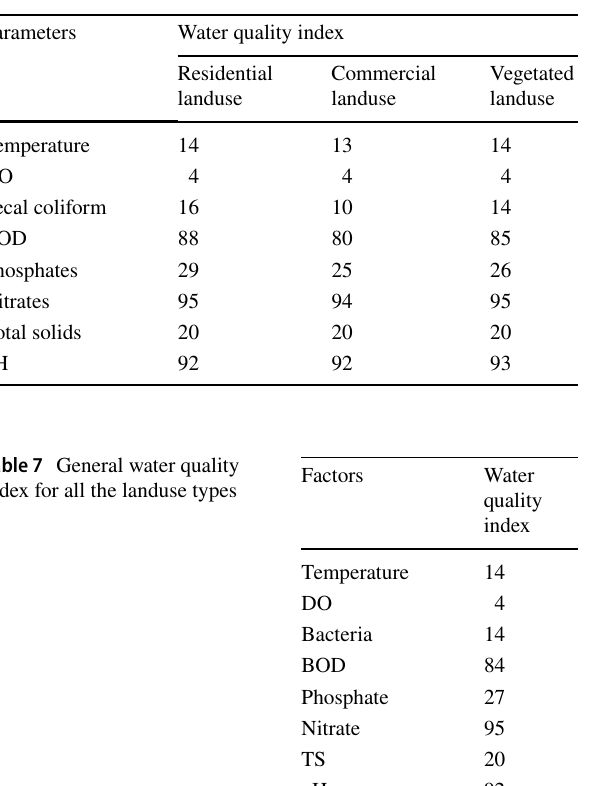
Table 6 Water quality index across the various landuse types. Source : Author’s fieldwork